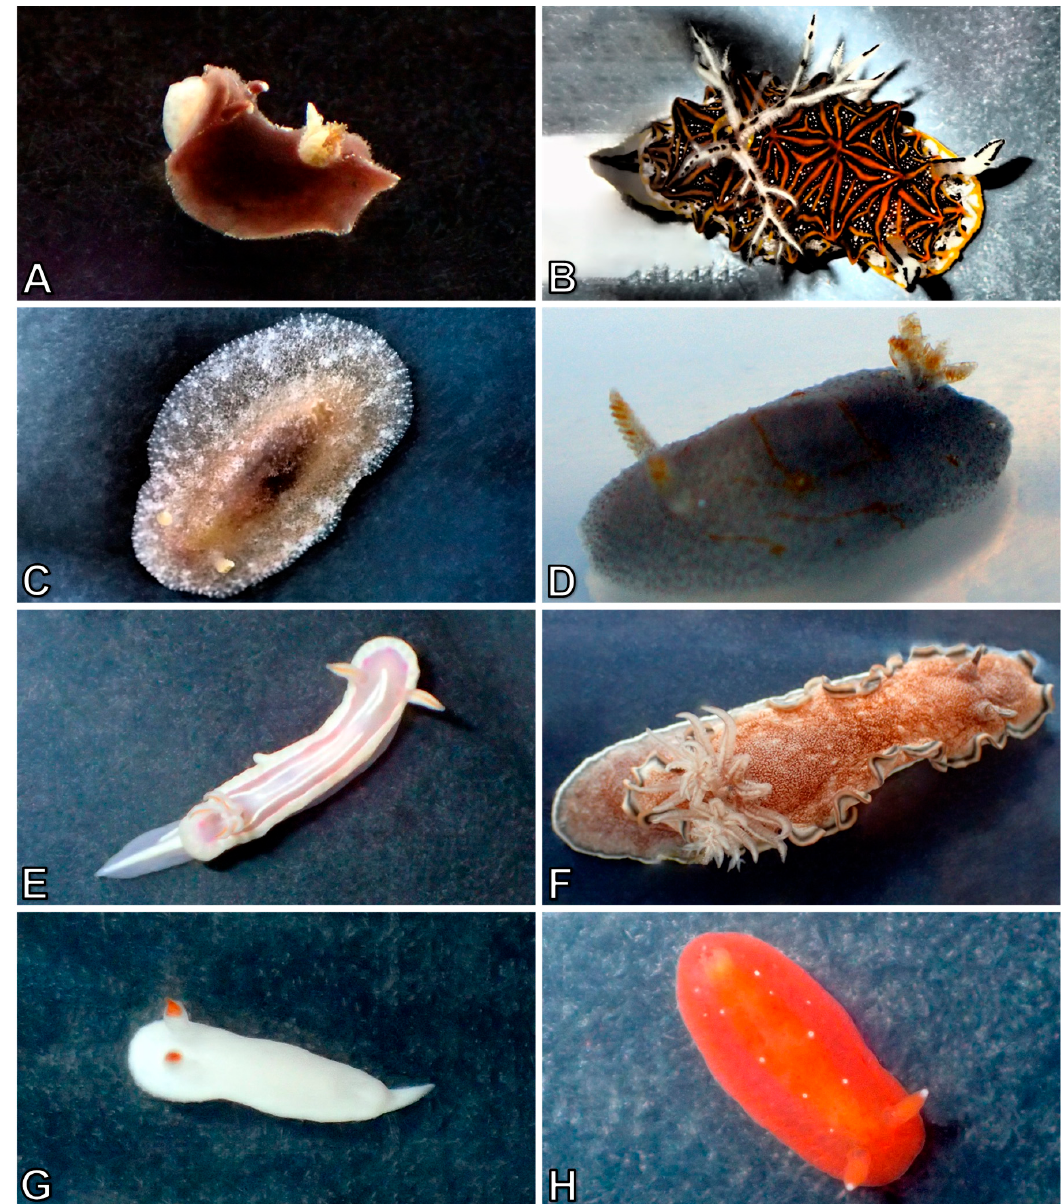
Figure 19. Nudibranchia - Doridina: ( A ) Diaulula spec. ( Diaulula sp. 1 in Gosliner et al. [11]: 197), Disp1_Bu-1; ( B ) Halgerda cf. tessellata ; ( C ) Discodorididae spec., Dosp17Bu-1; ( D ) Discodorididae spec., Dosp17Bu-2; ( E ) Ceratosoma spec. ( Ceratosoma sp. 1 in Gosliner et al. [11]: 266), Cesp1_17Bu-1; ( F ) Glossodoris hikuerensis ; ( G ) Verconia spec., Dosp17Bu-4; ( H ) Dendrodoris spec, Rosp17Bu-1.